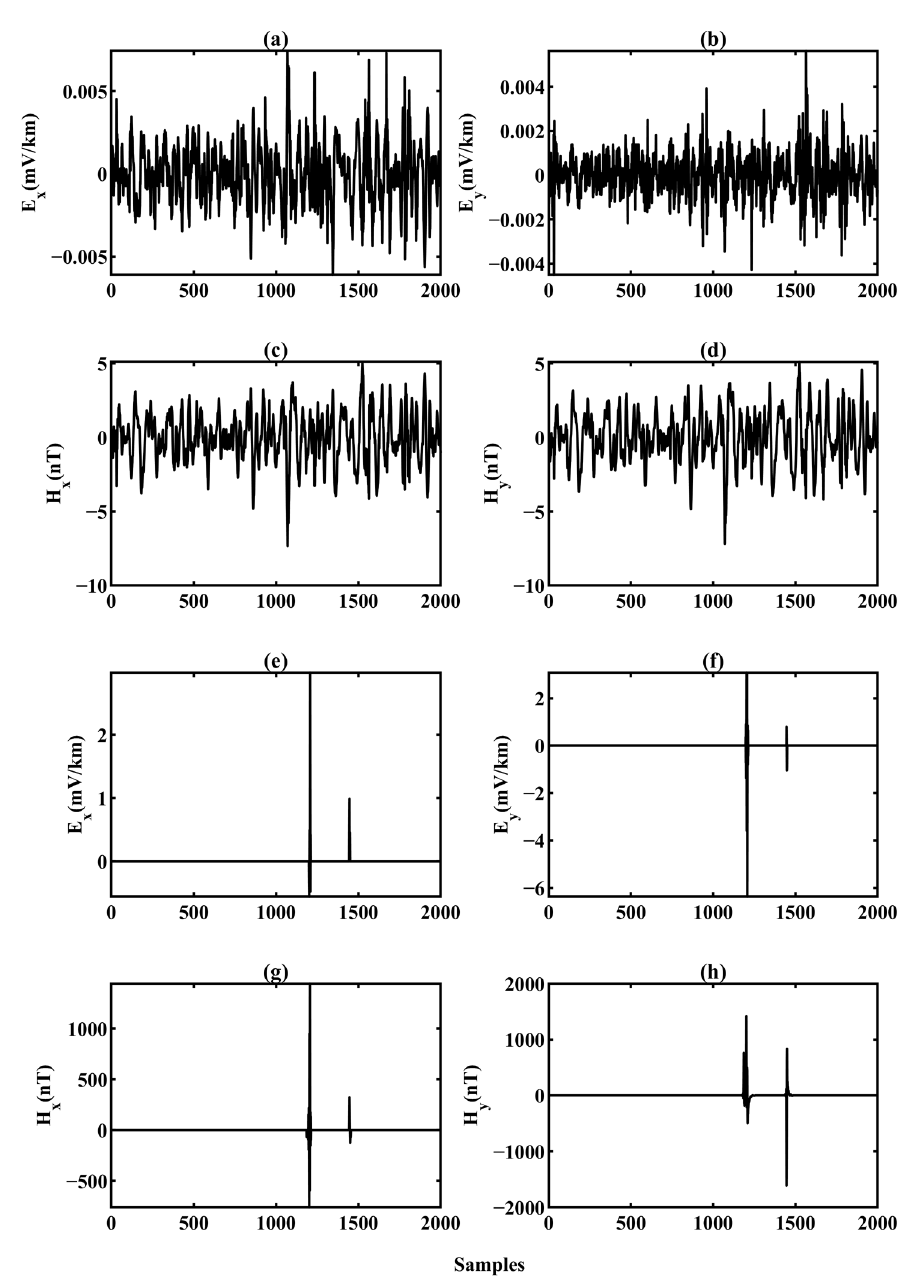
Figure 13. The denoising results of amplified section in the 5th test dataset. ( a – d ) are the denoising re- sults for e x , e y , h x , and h y , respectively. ( e – h ) are the extracted noise for e x , e y , h x , and h y , respectively.